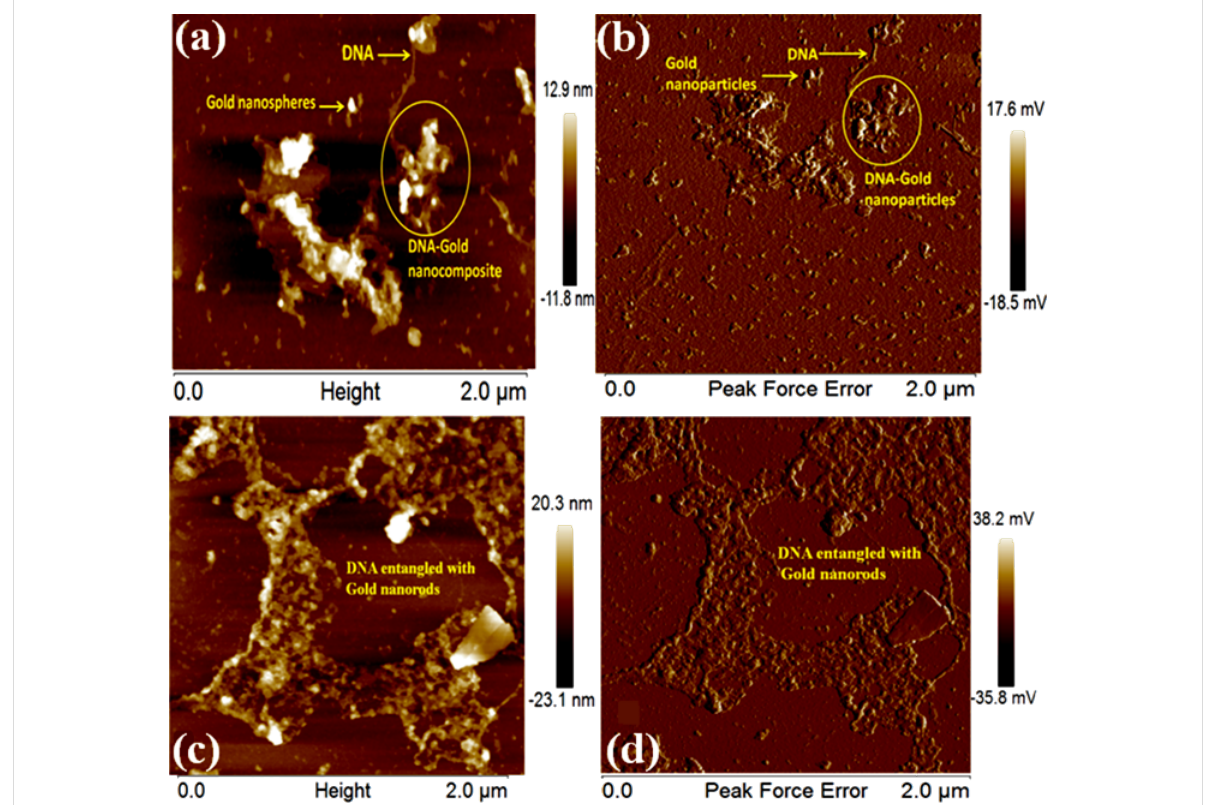
Figure 5: AFM images of (a,b) AuNS 1-DNA nanocomposites and (c,d) AuNR–DNA nanocomposites showing height and amplitude